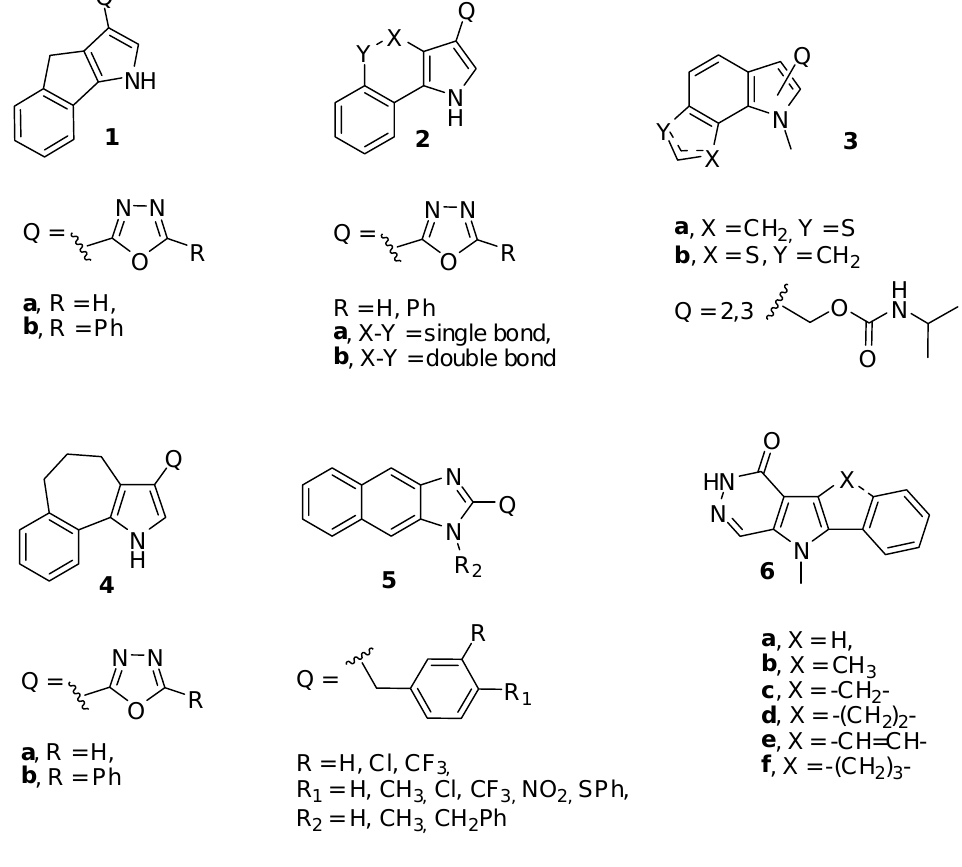
Figure 1. Chemical structures of some known anticancer agents synthesized by our